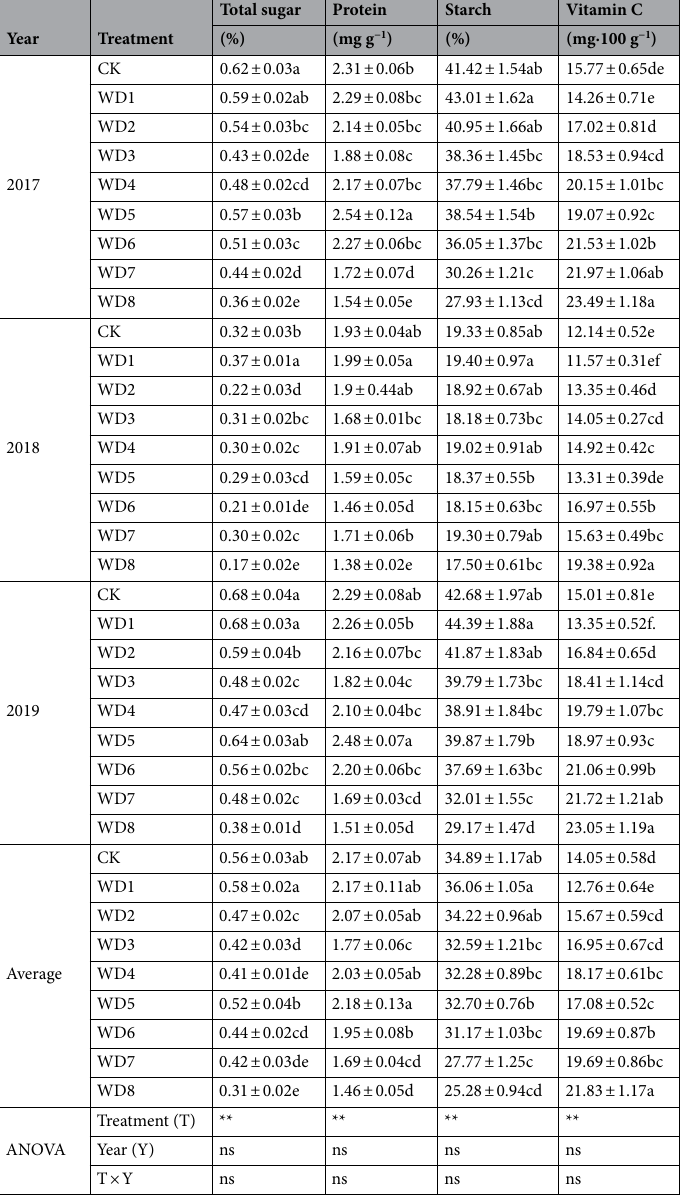
Table 3. Indices of potato quality at harvest in conventional irrigation (CK) and regulated deficit drip irrigation treatments in 3 years and averaged across years. Different lowercase letters within a column for a year or the average indicate significant differences among treatments ( P < 0.05). The irrigation treatments were conventional irrigation (CK) and mild or moderate water deficit during each of four stages of potato growth. Mild deficit was in treatments WD1 (seedling), WD2 (tuber initiation), WD3 (tuber bulking), and WD4 (starch accumulation); moderate deficit was in treatments WD5 (seedling), WD6 (tuber initiation), WD7 (tuber bulking), and WD8 (starch accumulation).Values followed by the same lowercase letters within each year are not significantly different at the P < 0.05 level. *, **, and ***are significant at the P < 0.05, 0.01, and 0.001 levels, respectively. ns not